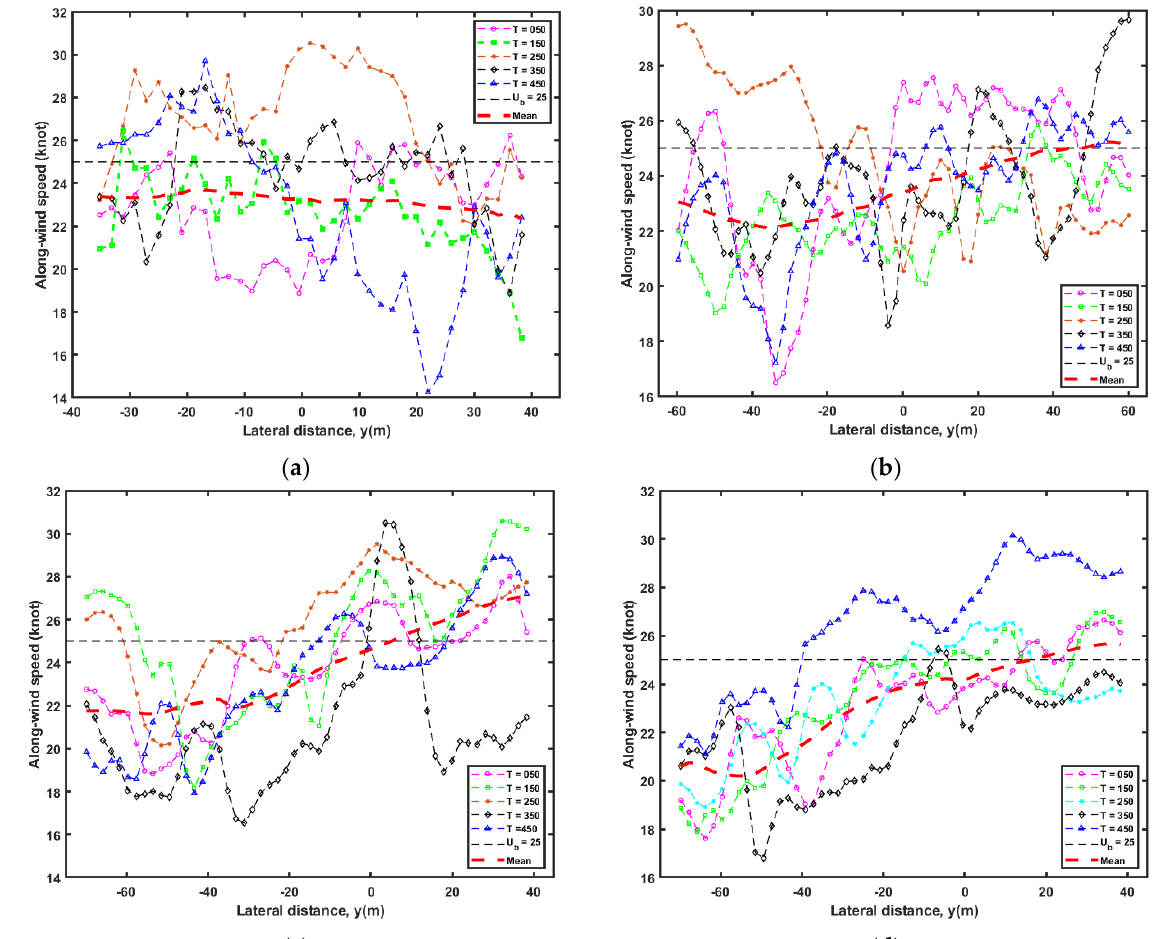
Figure 10. Changes of time-averaged along-wind speed lateral traverse at 𝑥 ≈ 337.5 m . aack- ground wind speed ( 𝑈 𝑏 ) is set as 25 knots.